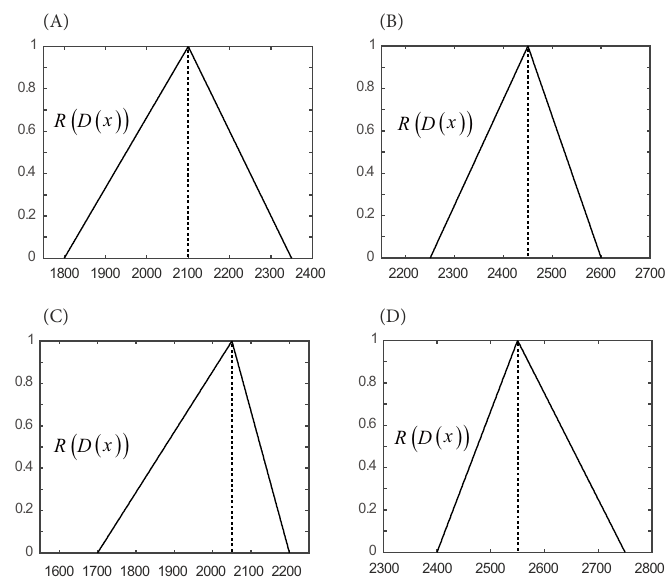
Table 19. Results of the extended FMIP model for order allocations Orders for suppliers Component 1